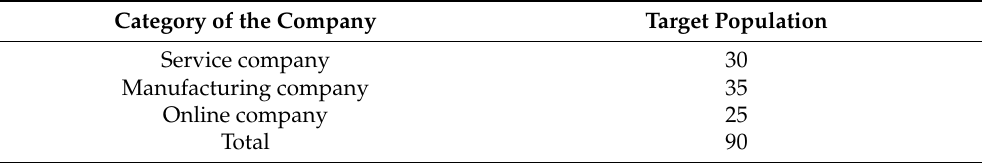
Table 1. Population of the study.